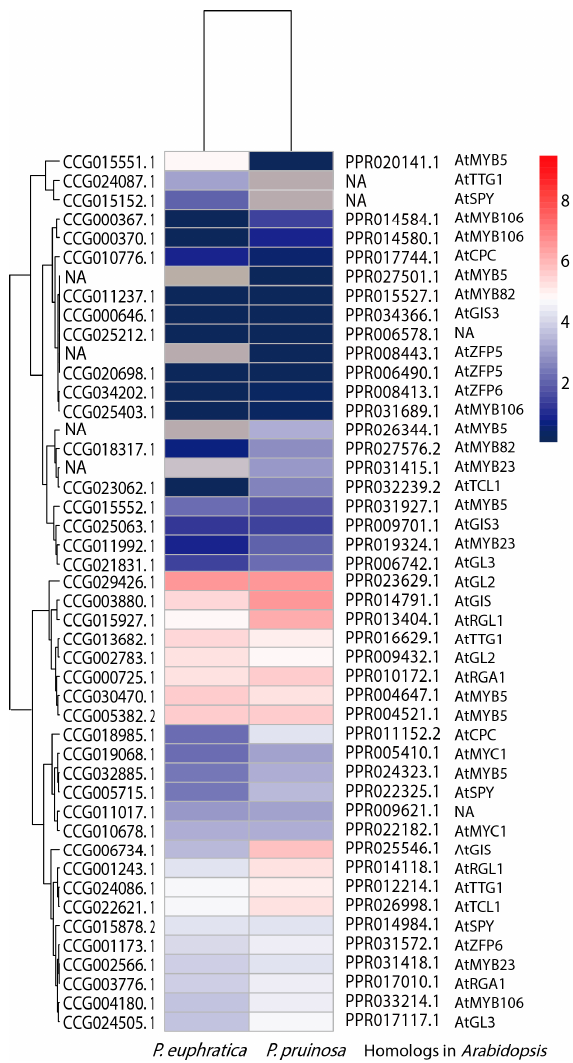
Figure 6. Expression of trichome-formation genes compared between P. pruinosa and P. euphratica . Heatmap of the expression of trichome formation genes in P. pruinosa and P. euphratica . The Illumina RNA-Seq data were analyzed, the fragments per kilobase of exon per million fragments mapped (FPKM) values were log2-transformed, and a heatmap was generated. NA indicates that no homologous genes exist.